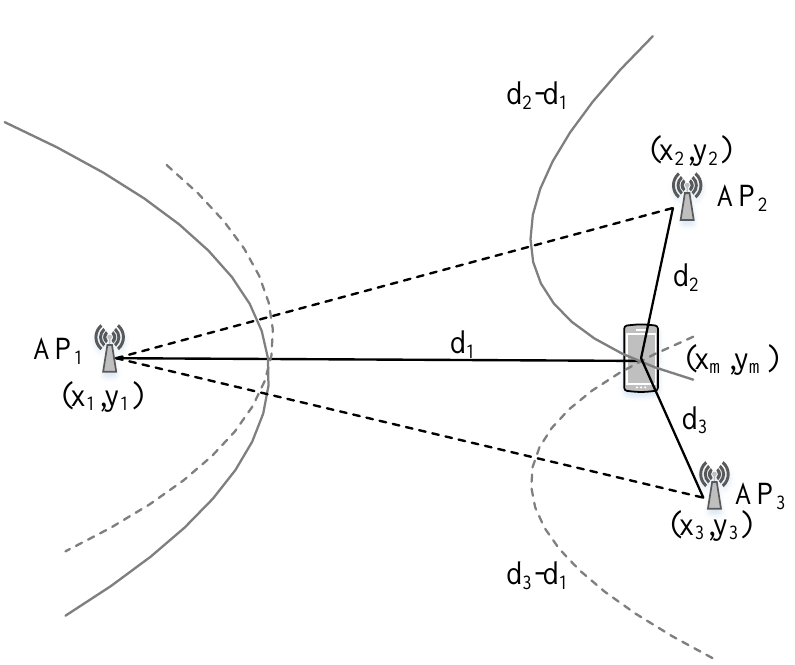
Figure 3. Localization based on time difference of arrival (TDOA)